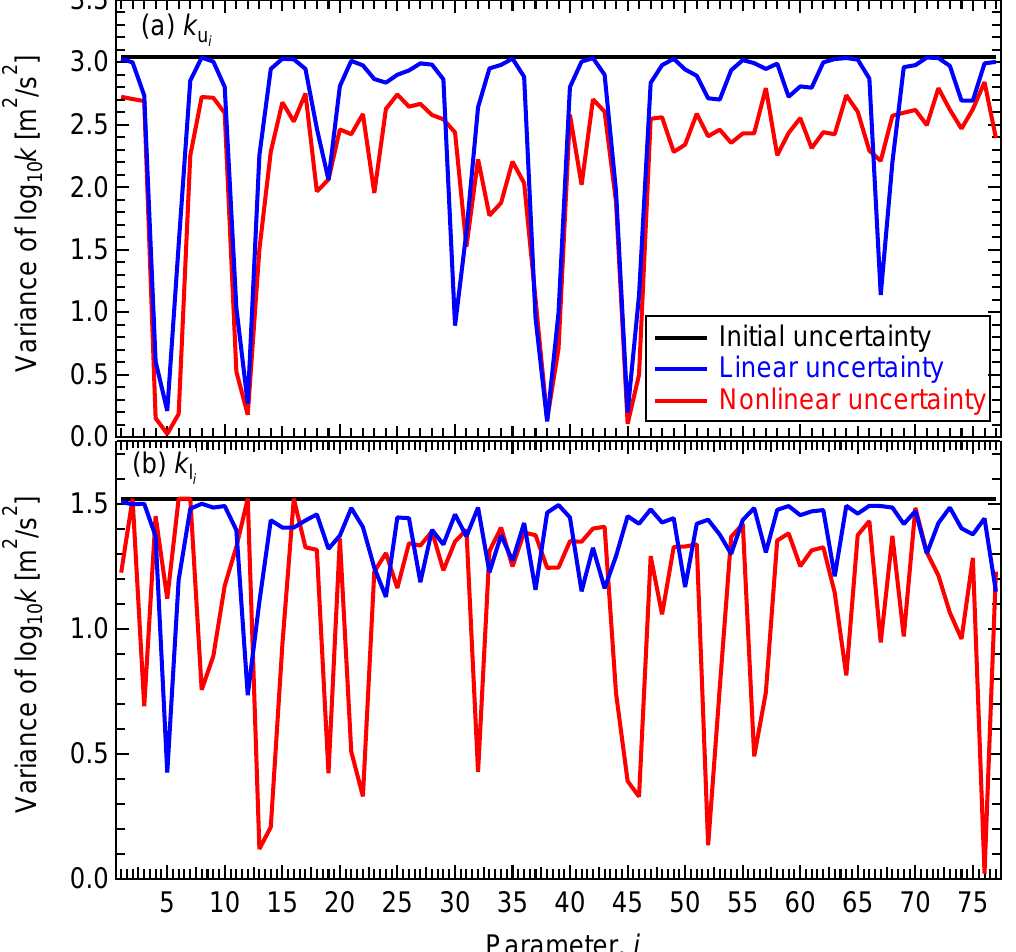
( k ) for the ( a ) upper and ( b ) lower layers according to the Figure 10. Variances of pilot-point log 10 linear (blue) and nonlinear (NSMC) uncertainty quantification techniques. The black lines indicate the a priori